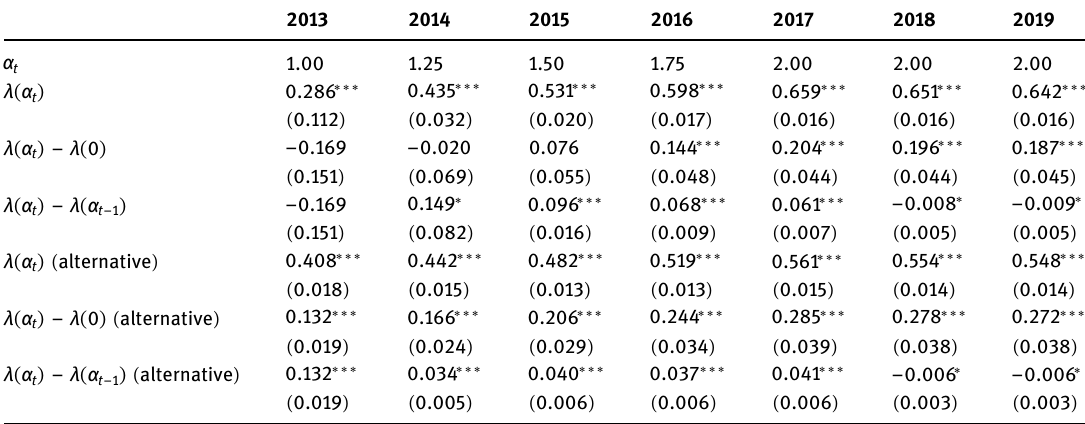
Table 3: E ff ect of pay - for - performance on mean